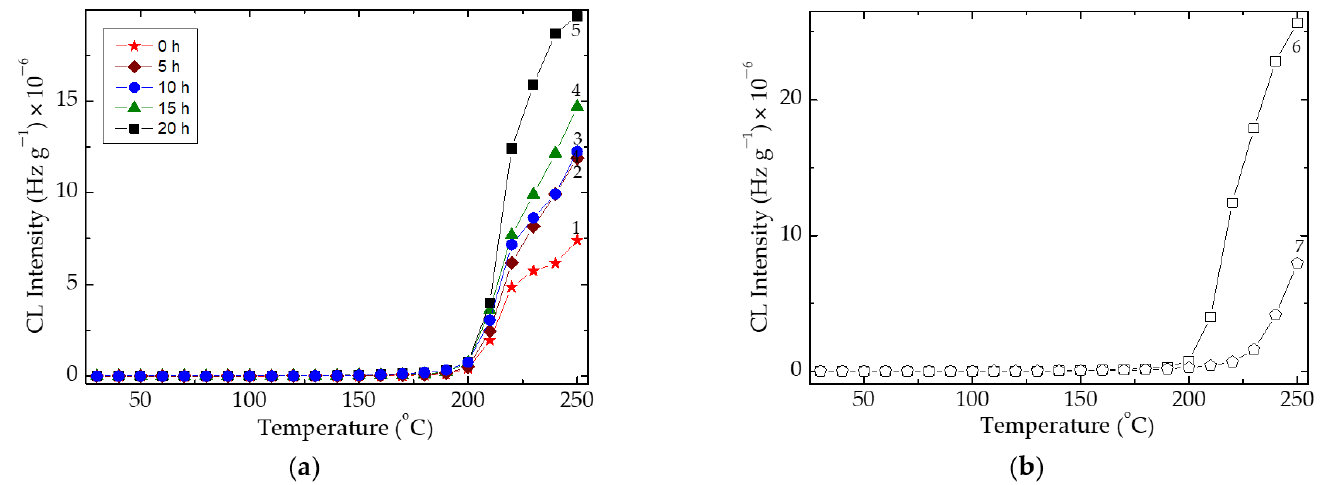
Figure 3. ( a ) Nonisothermal CL spectra recorded on SIS/graphene (1 wt%) samples after their thermal ageing treatment at 80 °C at various heating times. (1) 0 h; (2) 5 h; (3) 10 h; (4) 15 h; (5) 20 h; ( b ) nonisothermal CL spectra recorded on SIS (6) and SIS/graphene (1 wt%)/rosemary (0.5 wt%) (7) samples without pre-ageing. The heating rate of all measurement: 10 °C min −1 .